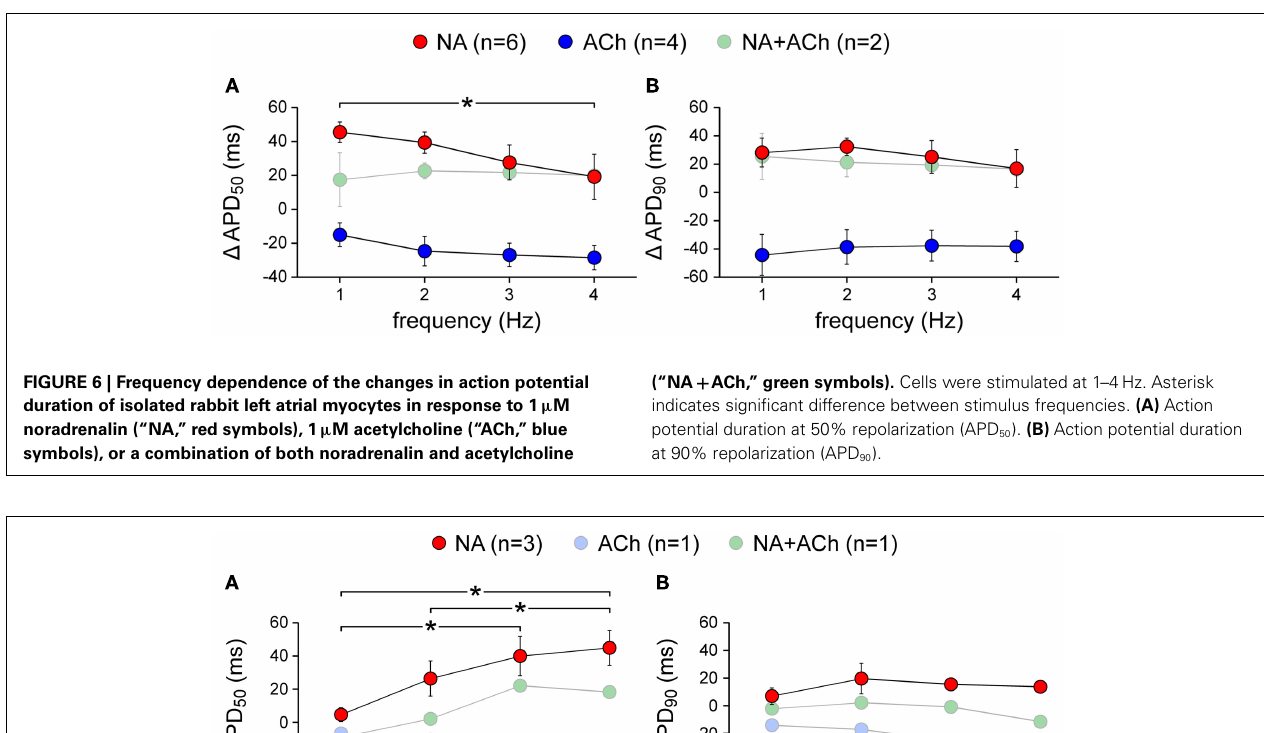
Concentration was varied between 1 and 1000nM. Asterisks indicate significant differences between concentrations. (A) Action